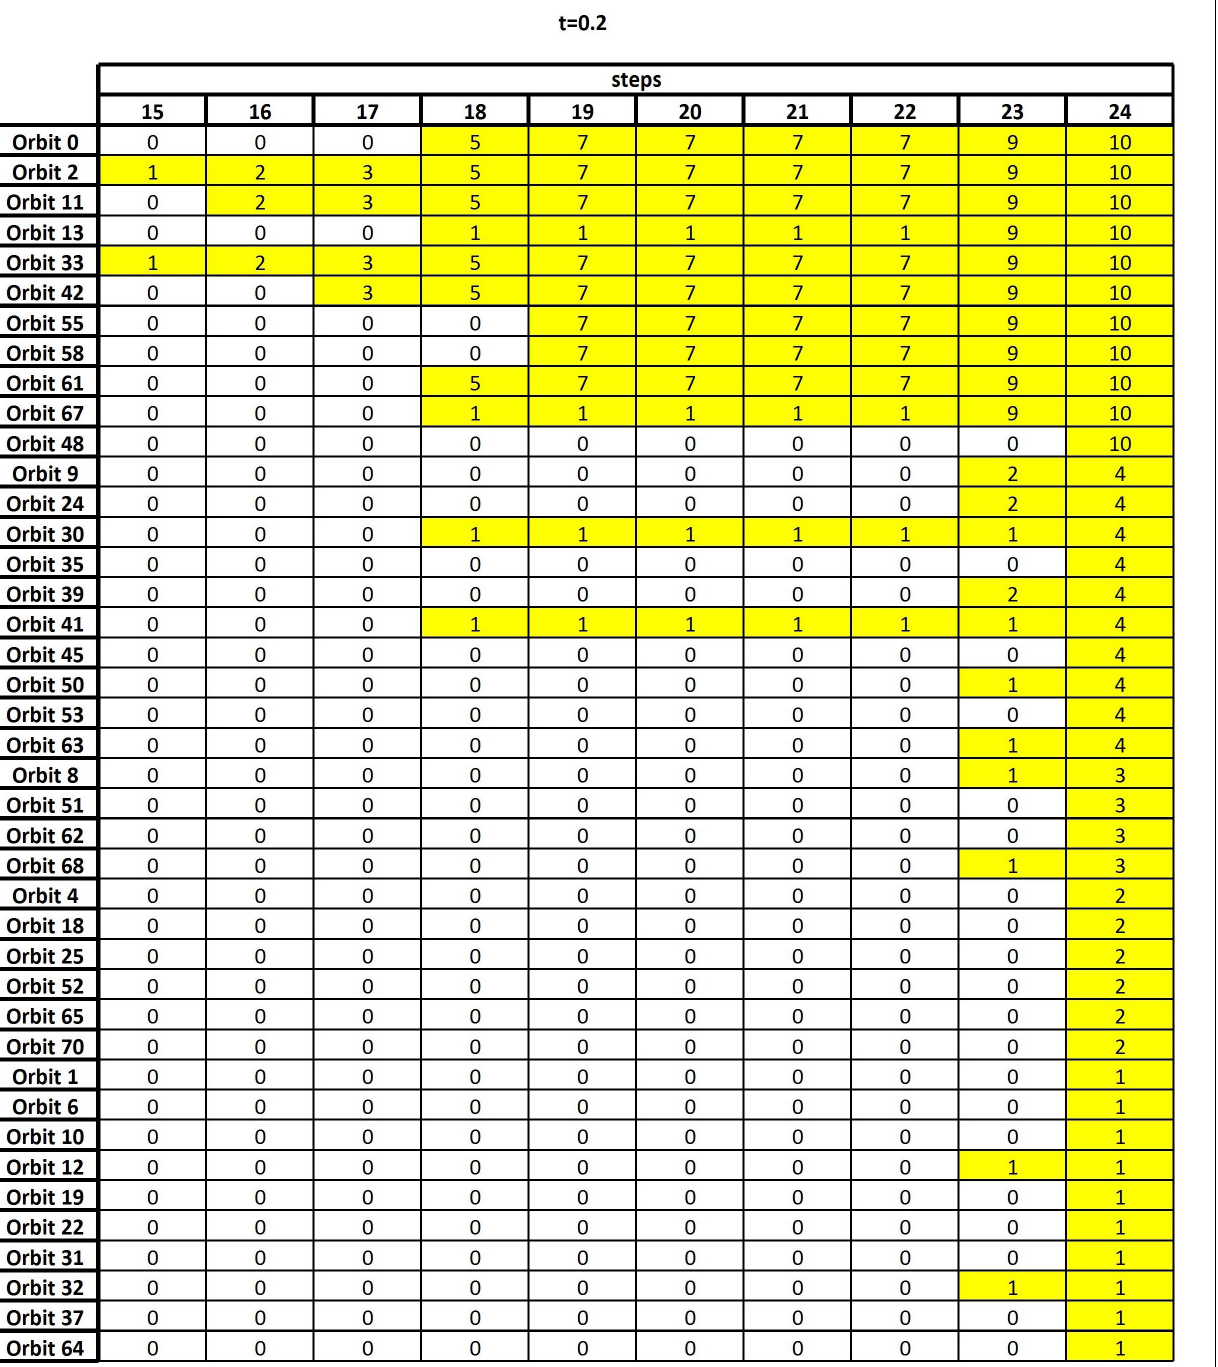
FIGURE 2 | The output table, i.e., the result of the algorithm of section “Frequency Table and Node Table,” when the threshold t = 0.2 is considered.